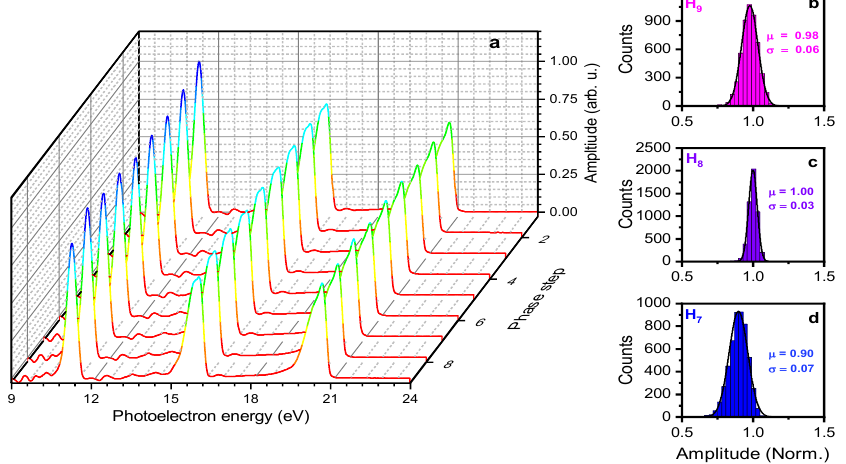
Figure 3. Amplitude fluctuations. ( a ) Average photoelectron energy spectrum for different phases in a phase scan without the dressing NIR field. Photoelectron spectra for each phase are normalized to the maxima of H 8 of the first phase value. ( b – d ) Distribution of the harmonic amplitudes for one phase value, H 9 ( b ), H 8 ( c ), and H 7 ( d ). In Panels ( b – d ), the amplitudes are normalized to the mean value of the amplitude of the harmonic H 8 .